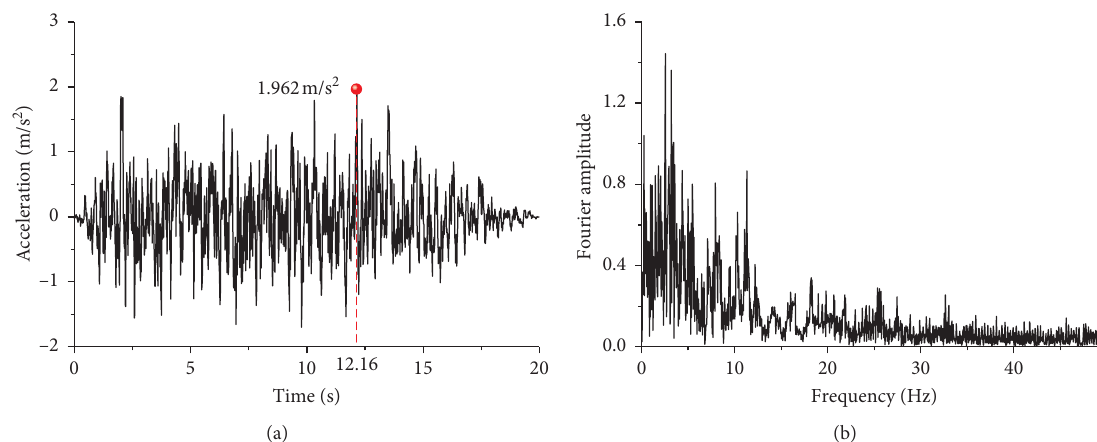
Figure 2: Time history (a) and Fourier spectrum (b) of input